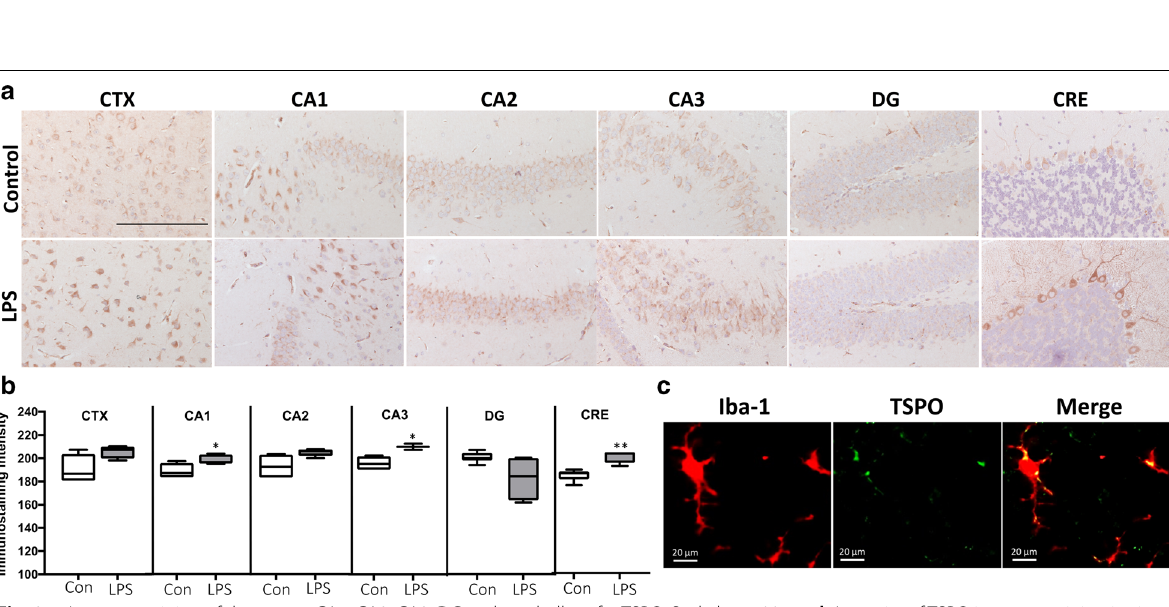
Fig. 9 a Immunostaining of the cortex, CA1, CA2, CA3, DG and cerebellum for TSPO. Scale bar: 100 µm. b Intensity of TSPO immunostaining in six selected brain regions of control and LPS‑injected mice: CTX‑Cortex, CA1, CA2, CA3, DG—hippocampus, CRE‑cerebellum. Data are mean ( n 3 mice per group). c Expression of TSPO (green) colocalized with the microglia marker Iba‑1 (red) ( n = * p < 0.05 , **p <